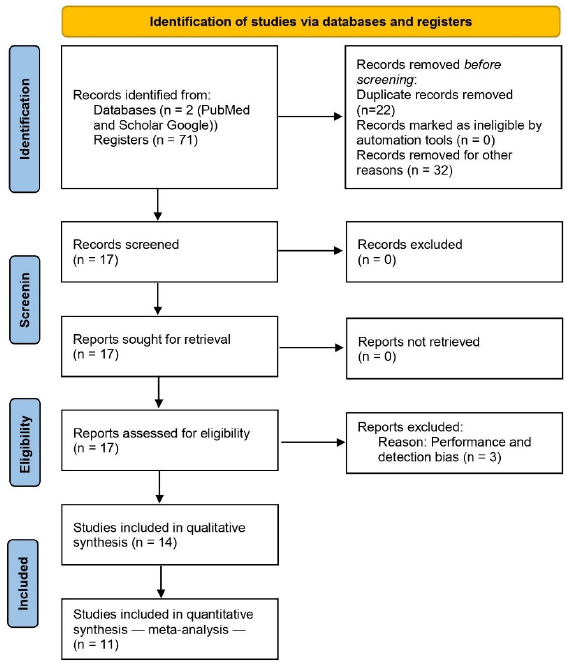
Figure 1. Study flowchart.